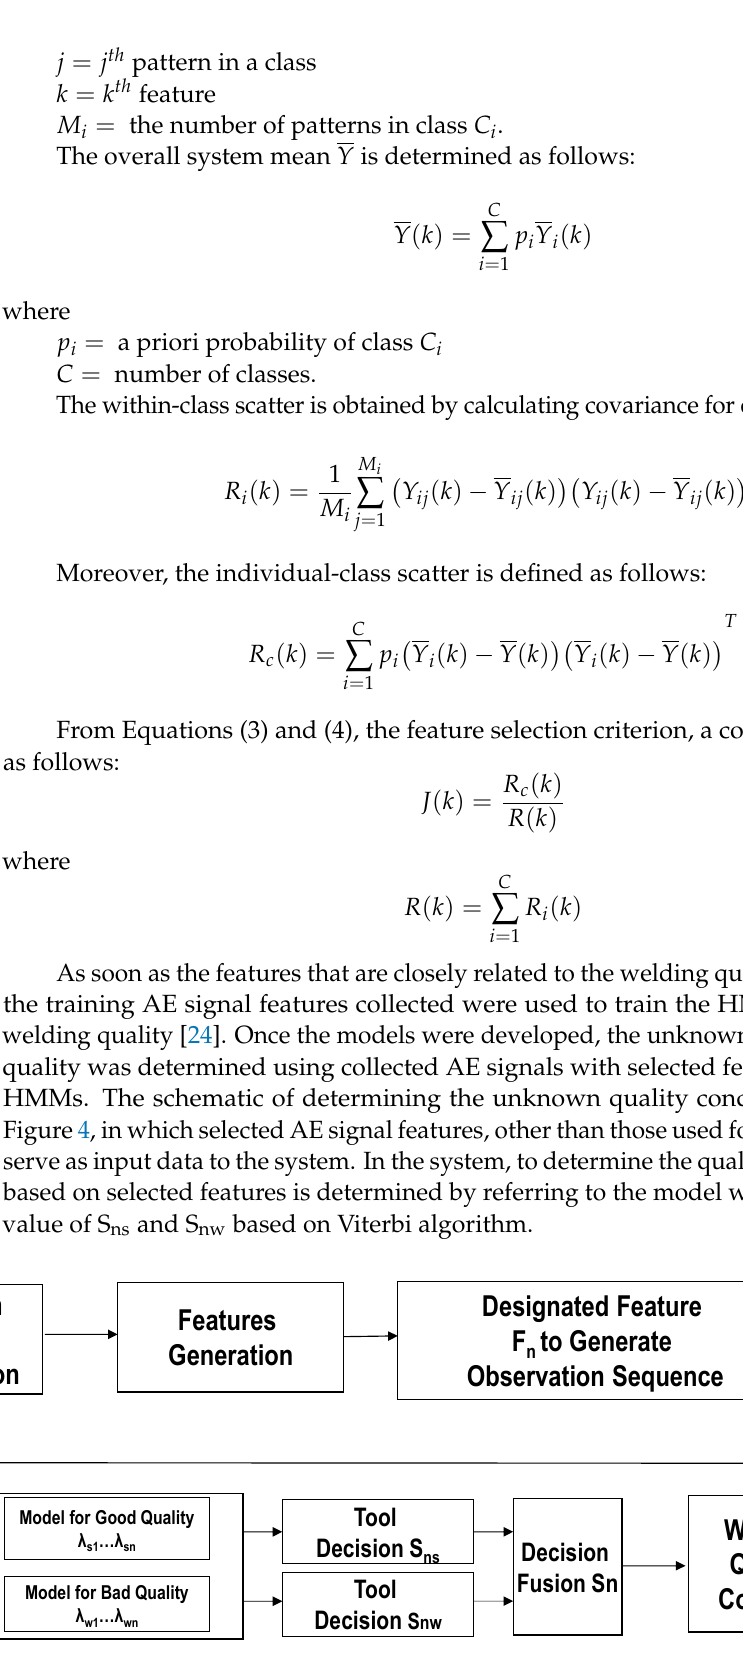
Figure 4. Schematic of determining the unknown quality condition by using the developed model.